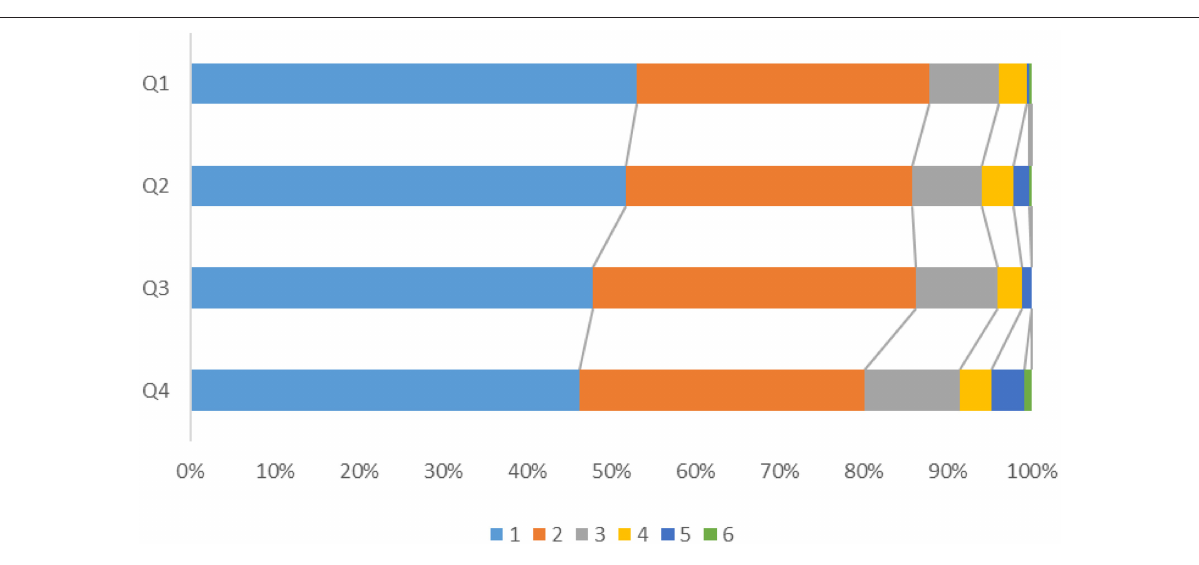
FIGURE 2 | Modified Rankin Scale (mRS) at 1 year according to QTd